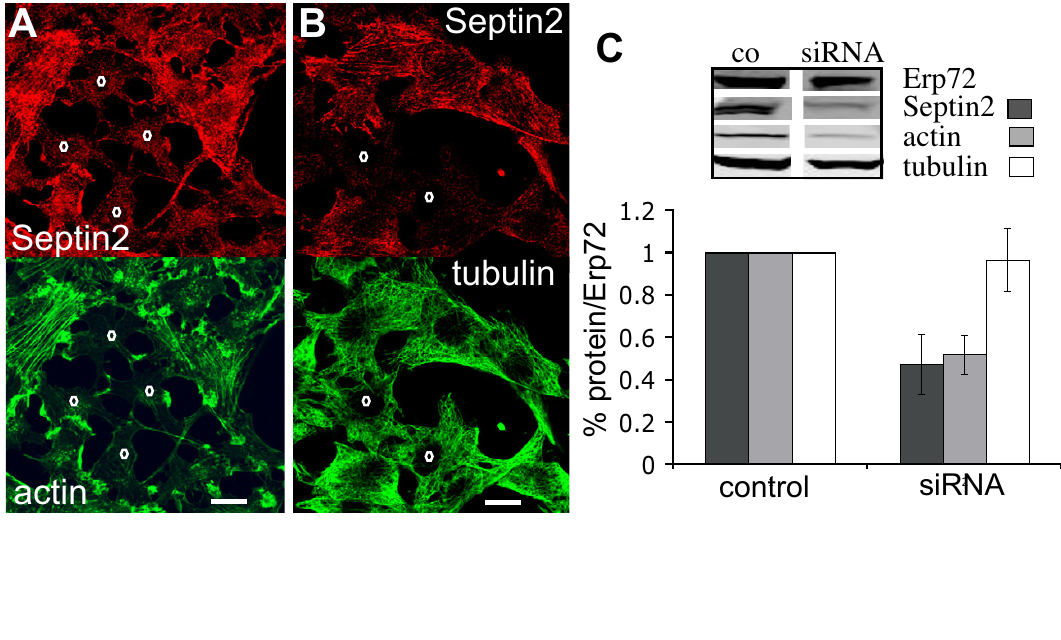
Figure 2 Knock down of Septin2 expression abolishes actin organisation. NRK cells were transfected with siRNA targeting Septin2. (A) Immunofluorescence 48 hrs after transfection. Cells with reduced level of Septin2 (red) have no actin bundles (red) (0). (B) Tubulin distribution (green) is unaffected in cells showing a decreased Septin2 staining (red) (0). (C) 48 hrs after transfection with siRNA NRK cells were lysed and immunoblotted for Septin2, actin, tubulin and Erp72. The amounts of Septin2, actin and tubulin were quantified and normalized to the corresponding amount of Erp72 to account for reduction in cell number upon siRNA treatment. co, control; Erp72, Endoplasmic Reticulum Protein, member of the protein disulfide iso- merase family. Similar results were obtained with Hela cells. A single confocal section is shown. Bars, 20 µ